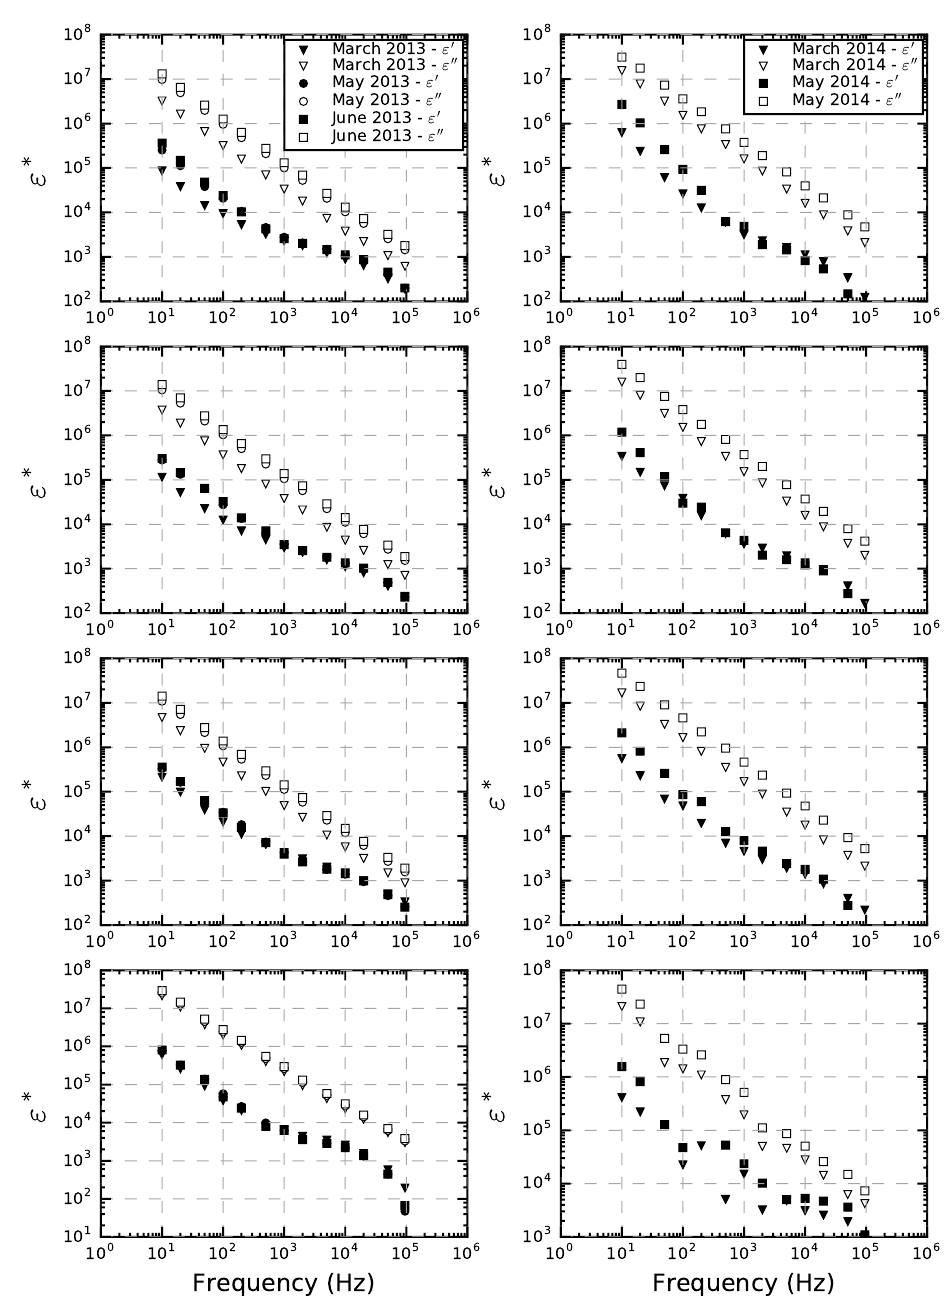
Figure 5. Real ( ε (cid:48) closed symbols) and imaginary ( ε (cid:48)(cid:48) open symbols) parts of the complex apparent permittivity at different depths. Left-hand column shows 2013 data, and the right-hand column shows 2014 data. Triangles show March data, circles show May, and squares show June